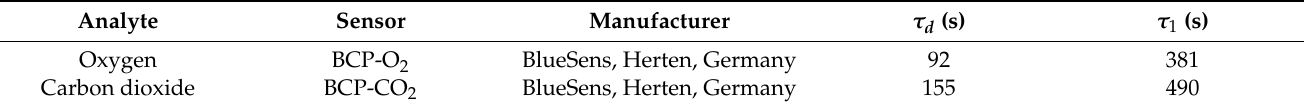
Table A1. Parameters for off-gas deconvolution. Delay times ( τ d ) and time constants ( τ 1 ) were derived from step experiments, where the reactor system was operated with water, but otherwise equal to fermentation conditions. Each parameter was derived from two-step experiments, where aeration was switched from a calibration gas mixture (2.00% O 2 , 8.99% CO 2 ) to ambient air (20.94% O 2 , 0.04% CO 2 ).